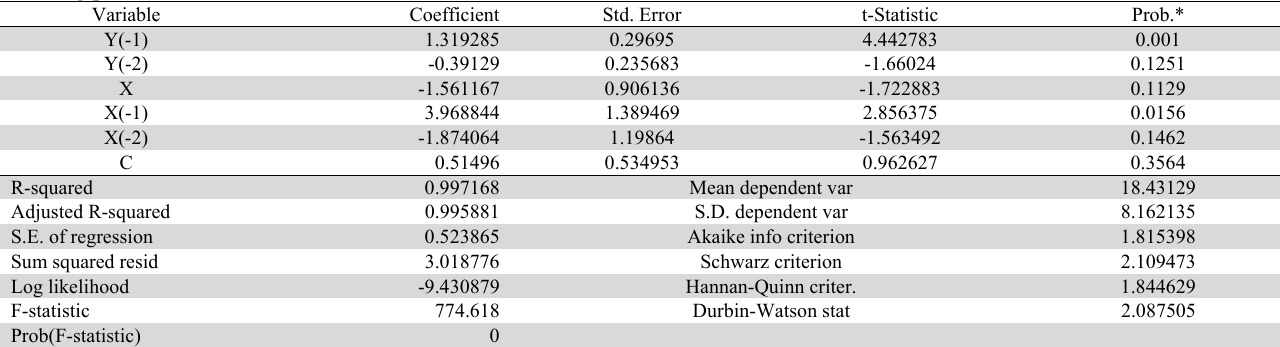
ECM Regression Case 2: Restricted Constant and No